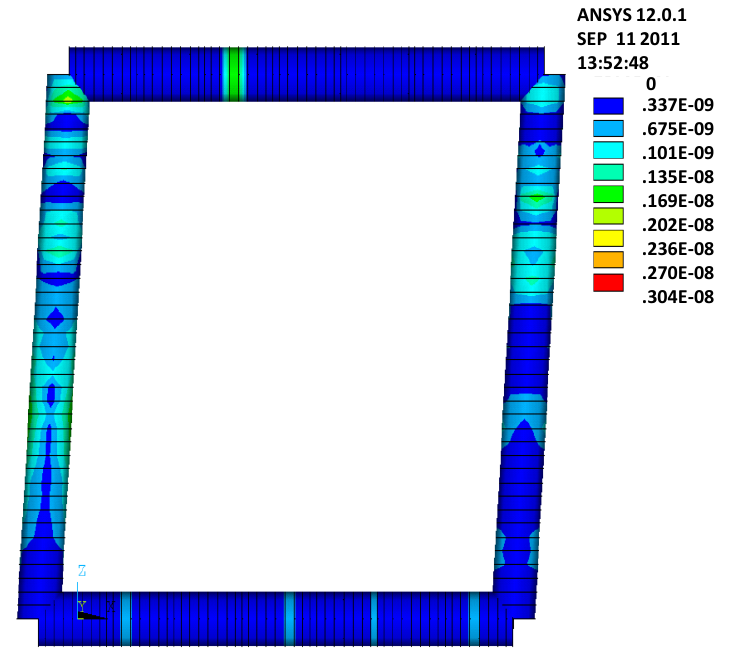
Figure 13. Stresses in a structure without shear panels and with arbitrary edge beams.